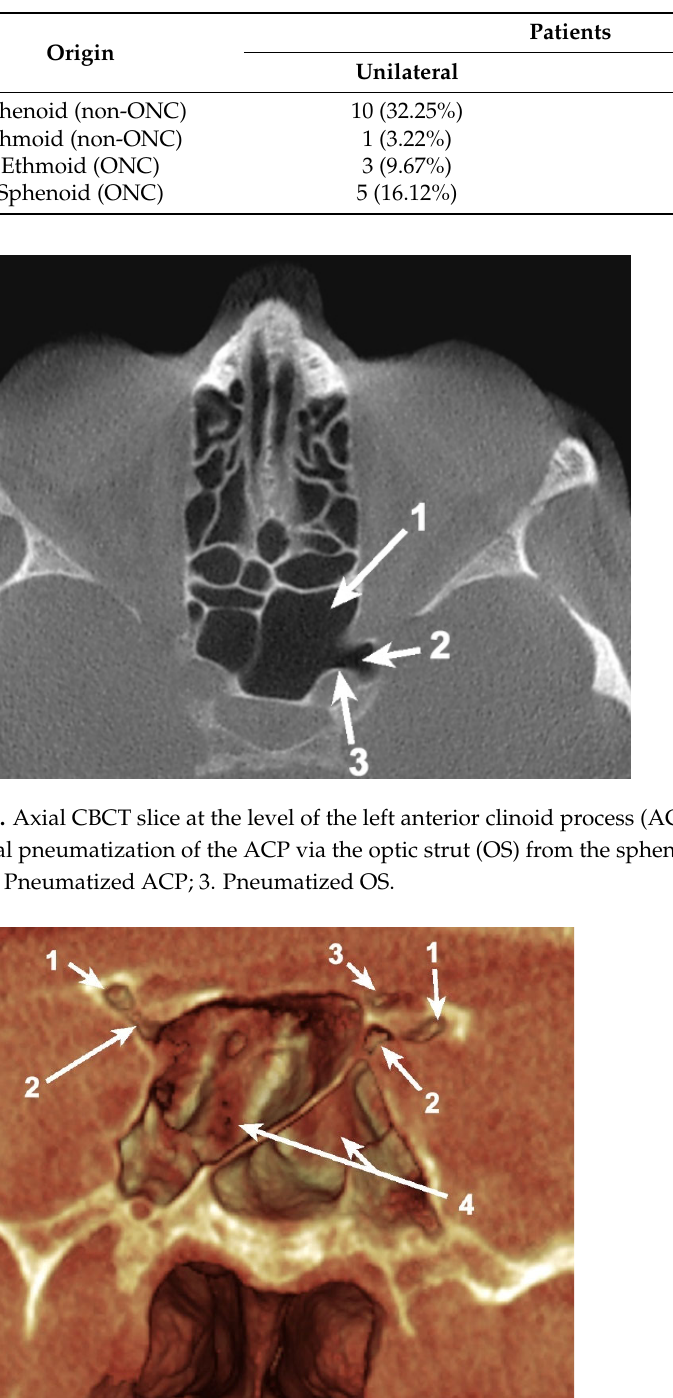
Table 2. Origin and prevalence of the pneumatization from the paranasal sinuses in the optic strut (OS) and the anterior root (AR) of the lesser sphenoidal wing. ONC—Onodi cell. N = 43 sides.